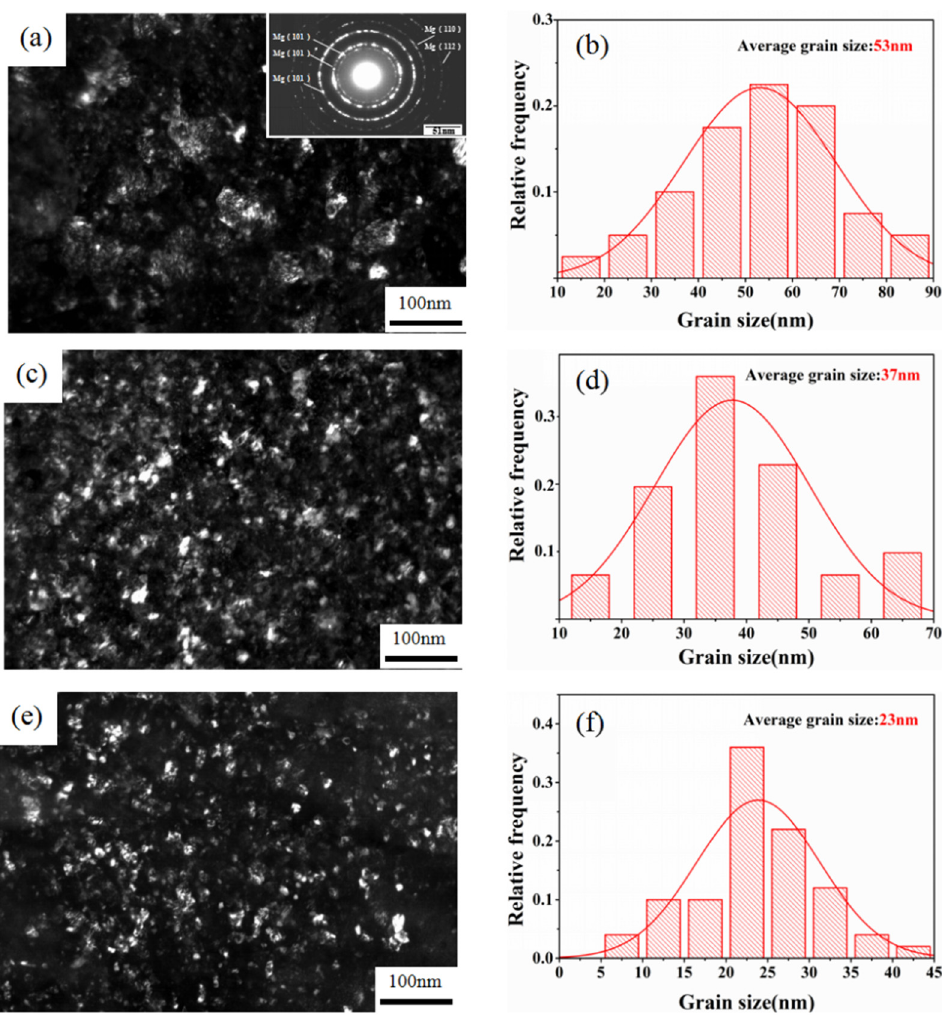
Figure 9. TEM images and corresponding grain size distributions of AZ31/TiB 2 composite powders with di ff erent TiB 2 additions after milling for 110 h: ( a , b ) 2.5 wt %, ( c , d ) 5 wt %, and ( e , f ) 10 wt %.